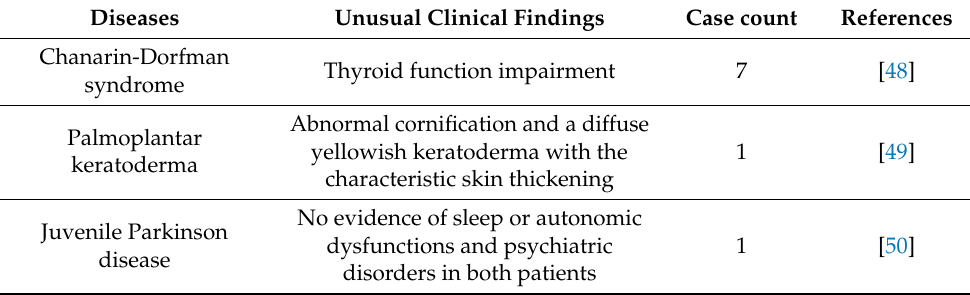
Table 3. Genetic diseases with unusual clinical findings among